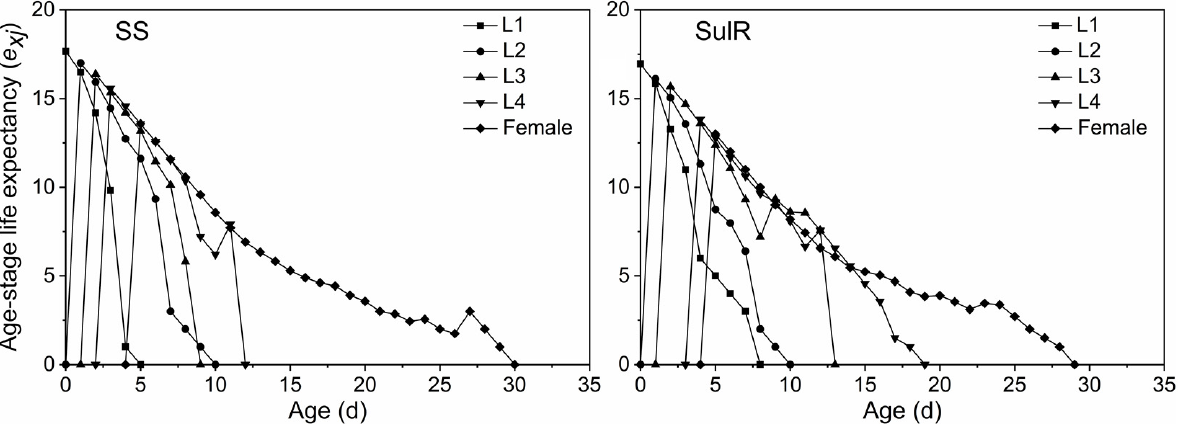
Figure 2. Age-specific survival rate ( l x ), age-specific fecundity of the total population ( m x ), and age-specific maternity ( l x m x ) of sulfoxaflor-resistant (SulR) and sulfoxaflor-susceptible (SS) Sitobion miscanthi populations. L1, first nymph stage; L2, second nymph stage; L3, third nymph stage; L4, fourth nymph stage.